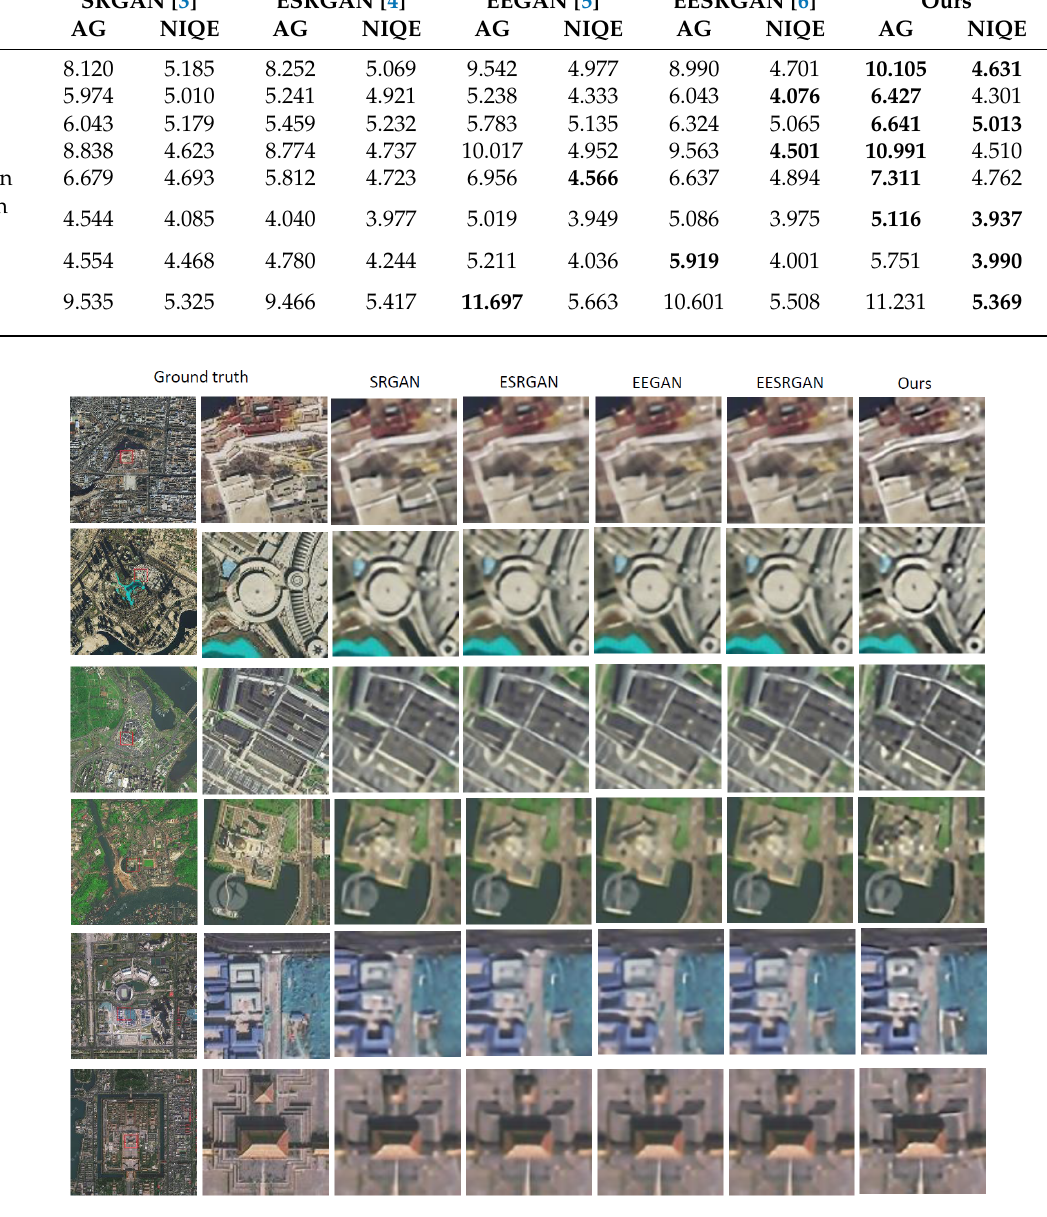
Figure 13. SR visual result comparison for all models in the SpaceWill